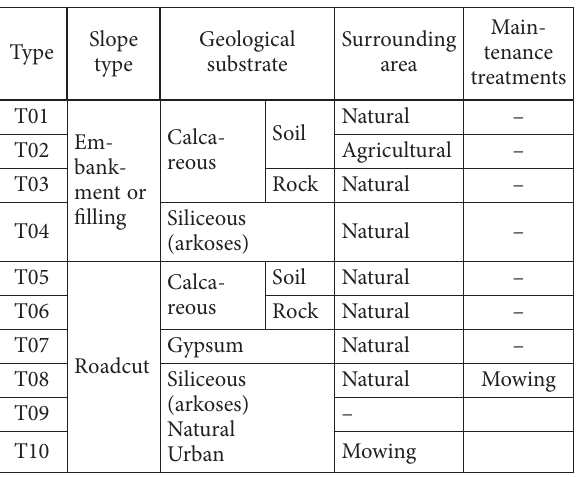
Table 2. Road slope